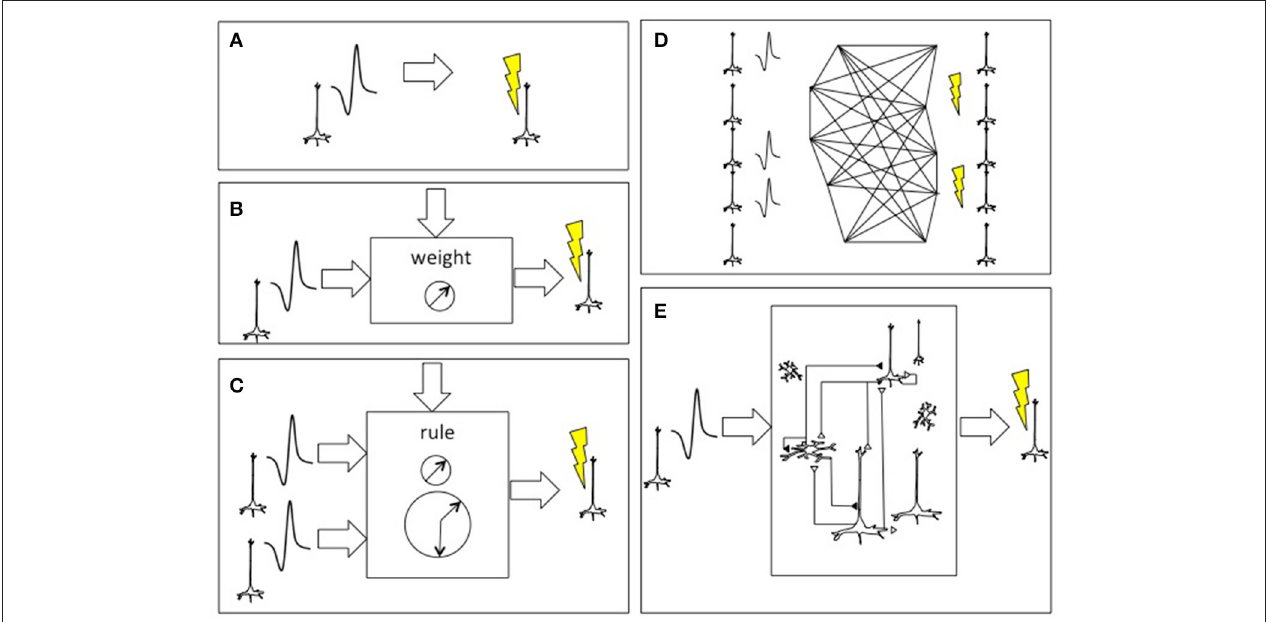
FIGURE 2 | Approaches to connecting the brain to itself. (A) In spike-triggered microsimulation, the detection of an action potential generated by a neuron recorded by an implanted microelectrode triggers focal microstimulation at microelectrodes located in another area of cortex (Jackson et al., 2006). (B) Rather than triggering stimulation in a direct, linear manner, the relationship between the spike detection and microstimulation could be governed by a weighting rule meant to emulate features of synaptic plasticity. (C) The external system could be altered to incorporate spike trains from two or more neurons and use spike-time dependent synaptic plasticity learning rules, including temporal coincidence detection, in order to trigger target. (D) As the BCI were able to record and stimulate more individual neurons, the external system could deploy learning rules to update the synaptic weight between all potential pairs, shown here on an image based on William James’ hypothesis about neural process interaction ( James, 1890). (E) Beyond direct mapping of recording to stimulation, or an interposed simplified neural network, more realistic cortical simulations could be used with the premise that the emulated cortex would be capable of performing its own “canonical” operations and would hence add a computation beyond connectivity (Nelson, 2002; Kouh and Poggio, 2008; Miller, 2016). Figure reprinted from Serruya and Kahana (2008) with permission from